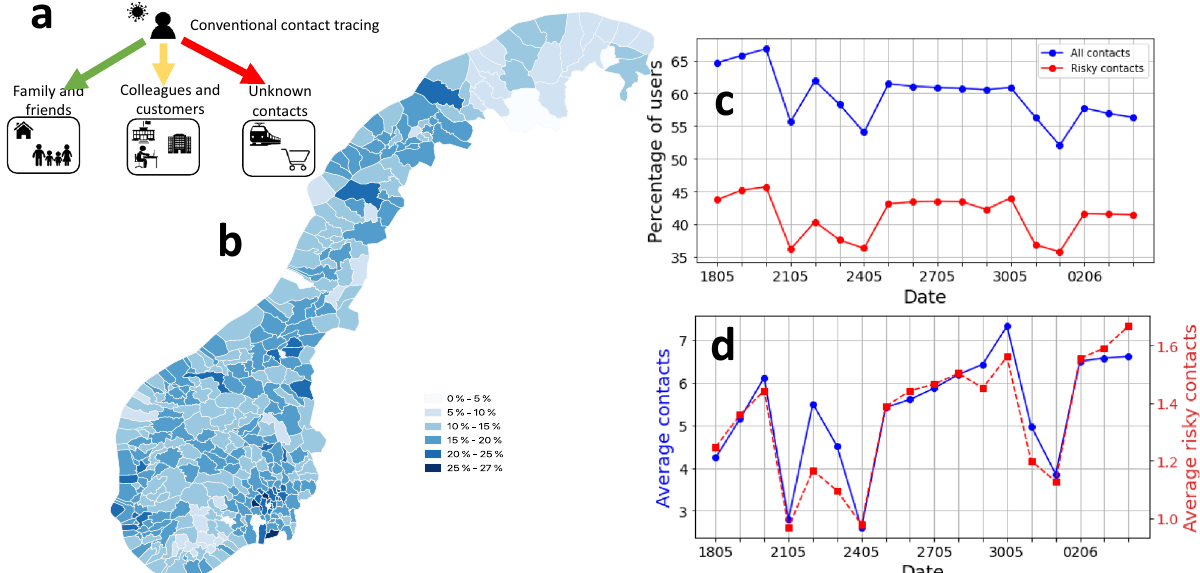
Fig. 1 Tracking the rollout of Smittestopp and the potential for identifying risky contacts. a Typical settings of social contacts, the colours of the arrows capture whether manual contact tracing can succeed in identifying the contacts in the respective setting (green means complete identi fi cation, yellow partial identi fi cation, while red means zero or minor identi fi cation), b The percentage of population over 16 year old that were using Smittestopp in each municipality, c the percentage of active users per day as well as the percentage of active users that were involved in risky close contacts (within 2 metres) that lasted 15 min or more, d The average number of contacts per day over time, all contacts (blue) and risky close contacts